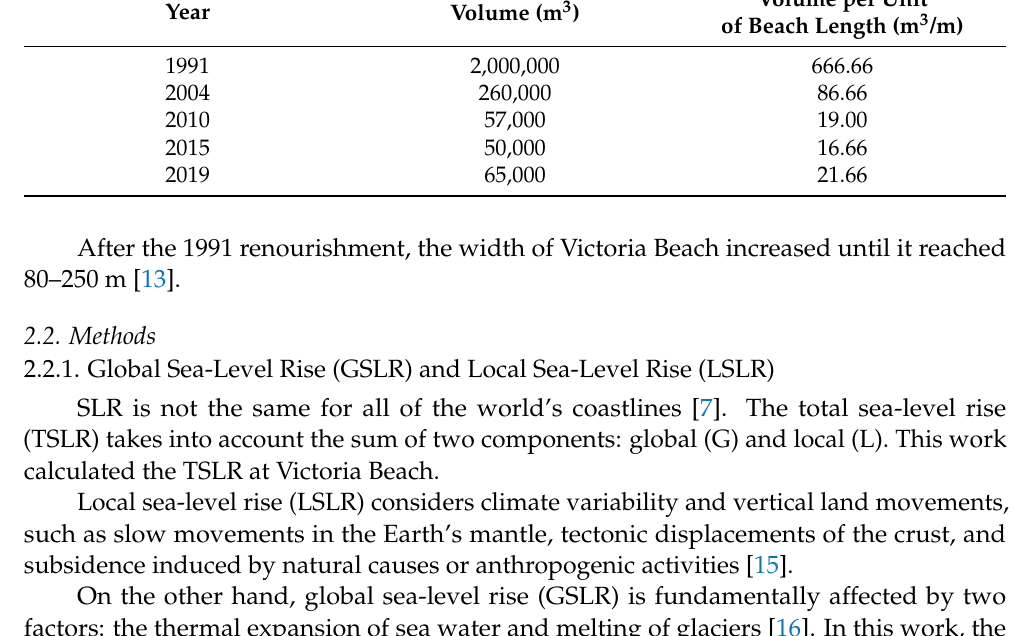
Table 1 . Volume of sand (m 3 ) deposited on Victoria Beach in the last three decades [13].